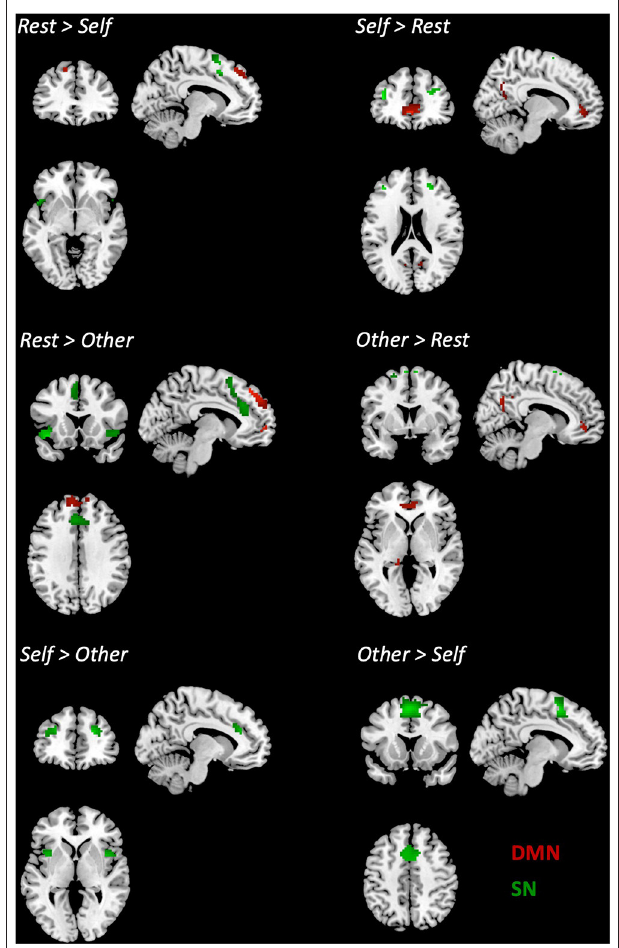
FIGURE 3 | Differences in the connectivity of the DMN and the SN between pairs of conditions. p < 0.05 FWE corrected, extent threshold k = 10 voxels.